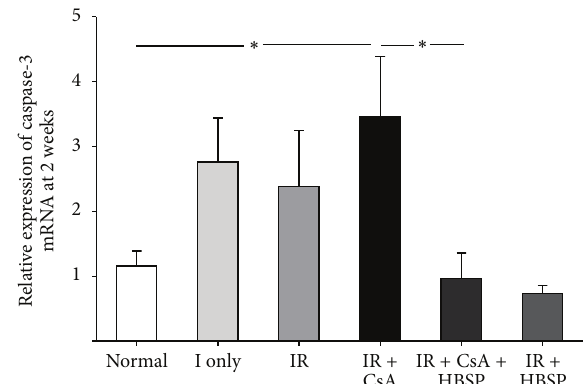
Figure 8: The level of caspase-3 mRNA in the kidneys, measured by qPCR, was predominantly increased by IR + CsA compared with the normal group but significantly decreased by the treatment of HBSP. Data are expressed as mean ± SEM, 𝑛 = 6 . ∗ 𝑃 < 0.05